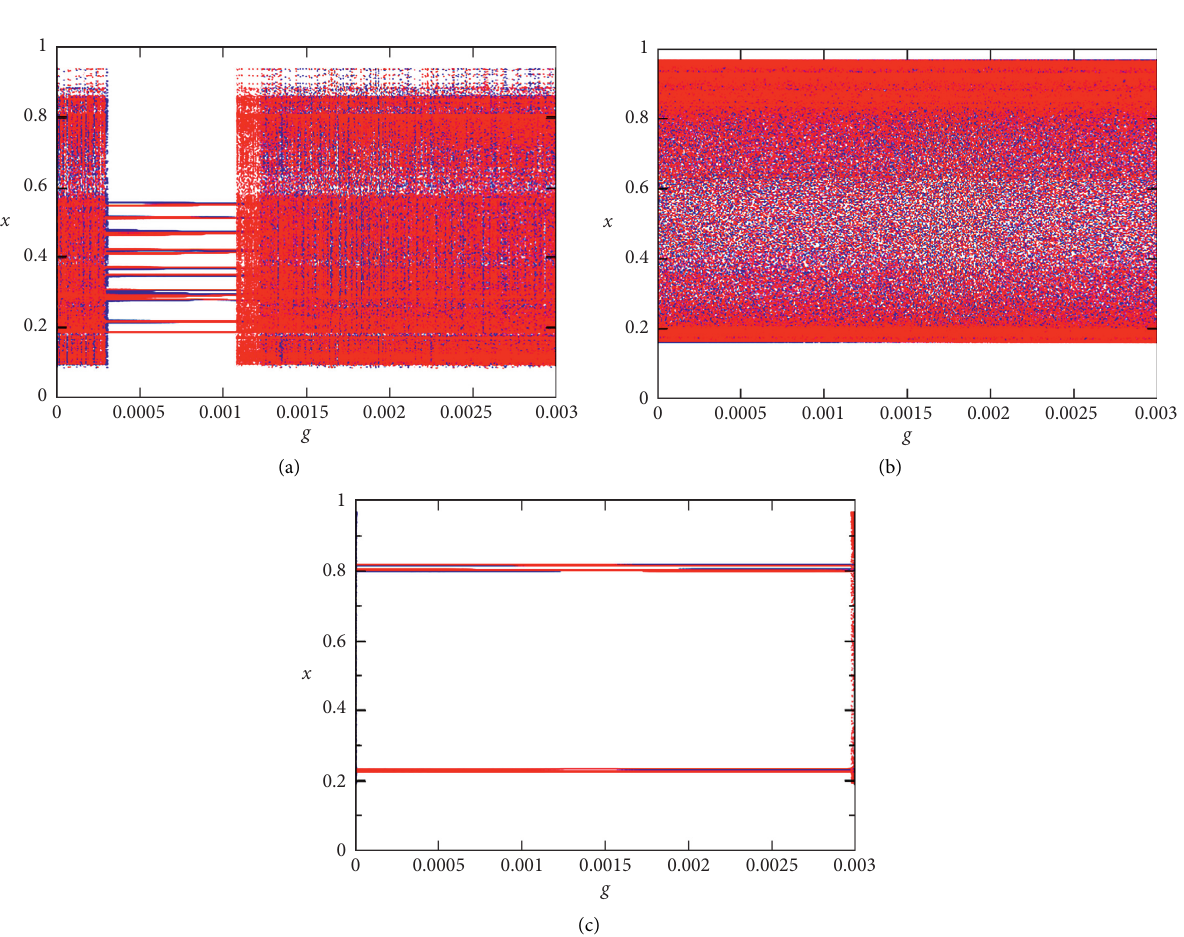
Figure 15: Effect of parameter β on bifurcation diagram of nonlinear chemical reaction with ω � 0.0481, Ω � ( α � 0.28: (a) β � 0.04; (b) β � 0.06; (c) β � 0.07. Bifurcation diagrams and its corresponding Lyapunov exponent are obtained by scanning the parameter g upwards (blue) and downwards (red).